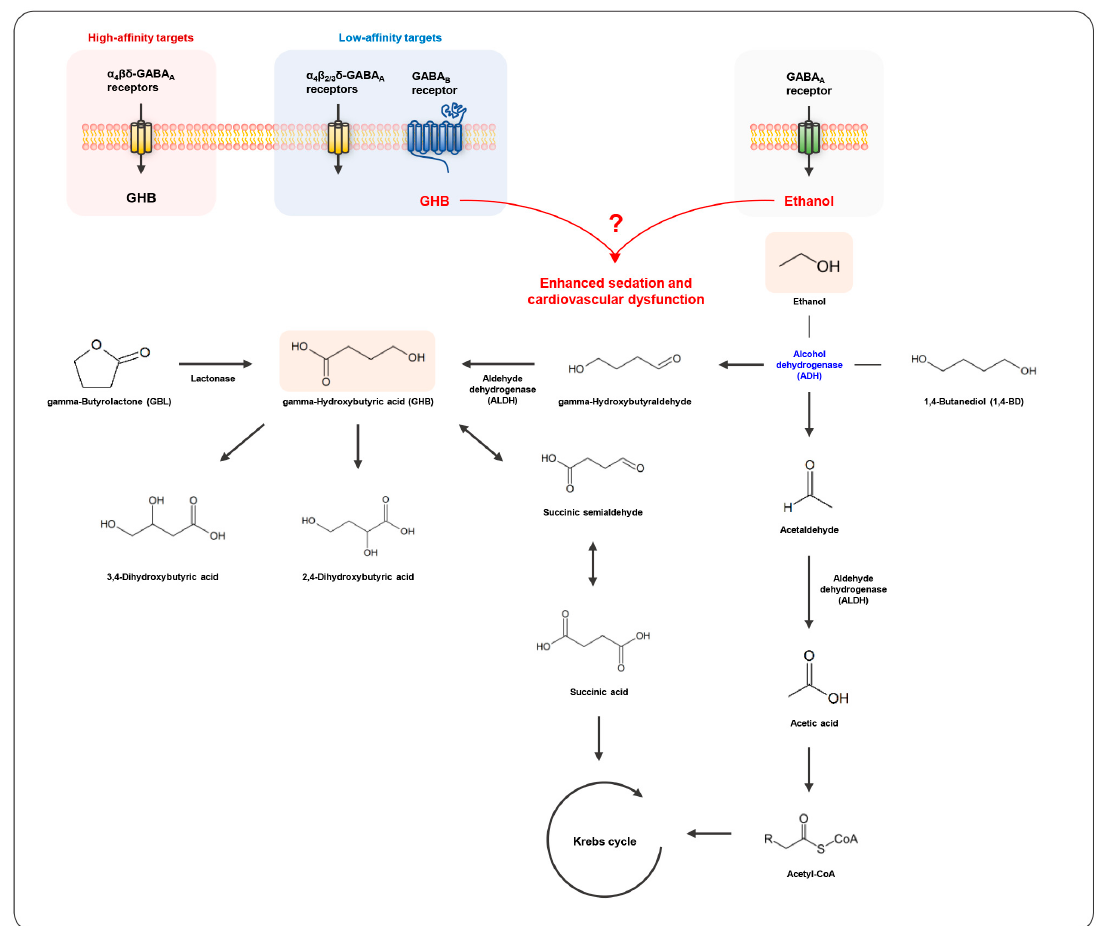
Figure 2. Interactions between gamma-hydroxybutyric acid (GHB) and ethanol.